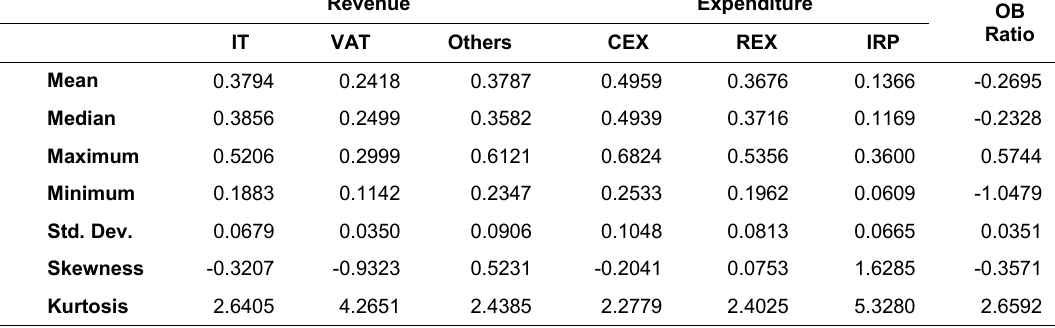
Table 1. Descriptive